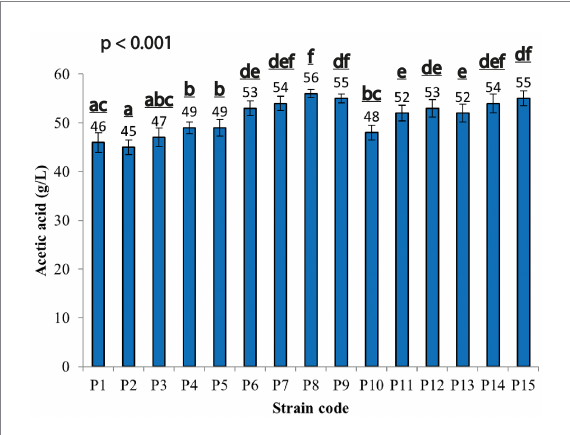
FIGURE 1 Acetic acid production by spore former-acid producing strains at 30 ± 2 ° C during 30 days of cultivation. Each value is the mean of three parallel replicates ± standard deviation. Significant differences among the samples in acetic acid production were represented by different